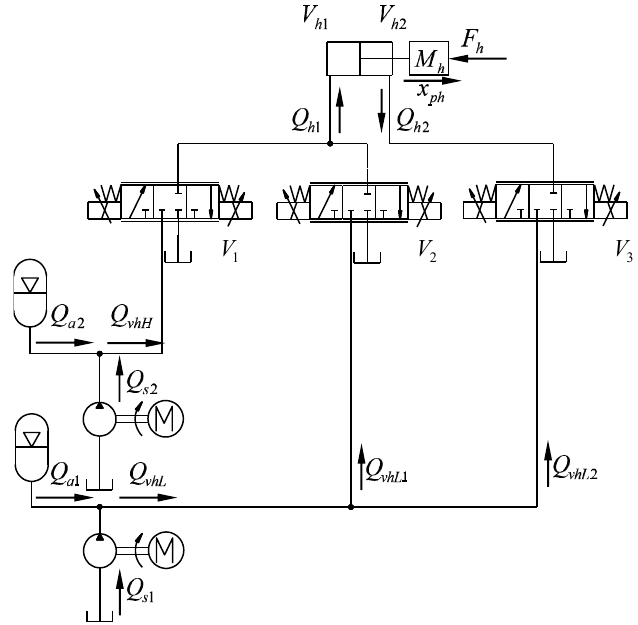
Figure 5. Schematic of the simplified hip joint SMISMO system. Neglecting the leakage, the pressure dynamics of the cylinder chambers can be derived by